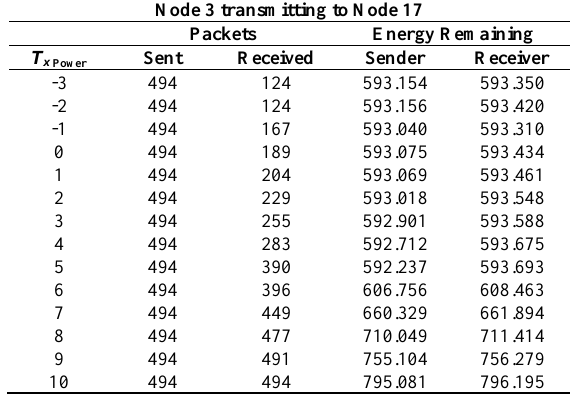
Table 15. Summary of the results under Scenario 2b .